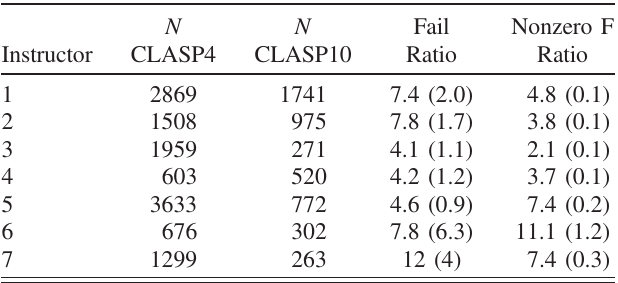
TABLE III. Seven instructors used both grade scales at various times. N ’ s are the numbers of students taught under the particular grading regime. The fail ratio is the fraction of that instructor ’ s students with course grades less than C − under percent grading divided by that fraction under 4-point grading. Similarly, the nonzero F ratio is the fraction of that instructor ’ s exam-item grades that were nonzero F ’ s under percent grading divided by that fraction under 4-point grading. Standard errors are in